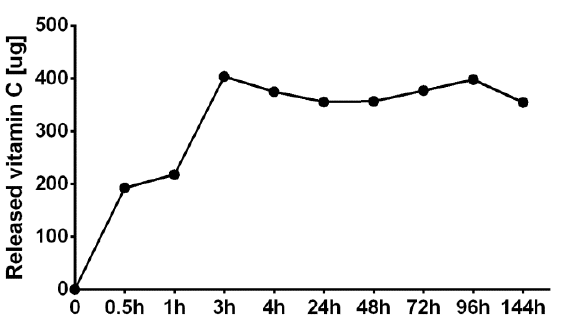
Figure 2. Cumulative vitamin C release profile from the CHN/A + vit C film.